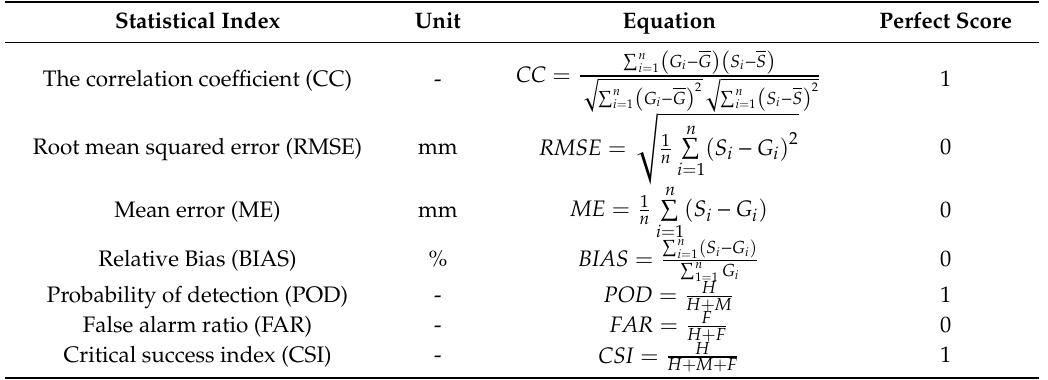
Table 2. Statistical indices used for evaluating climate forecast system reanalysis (CFSR) and CHIRPS precipitation